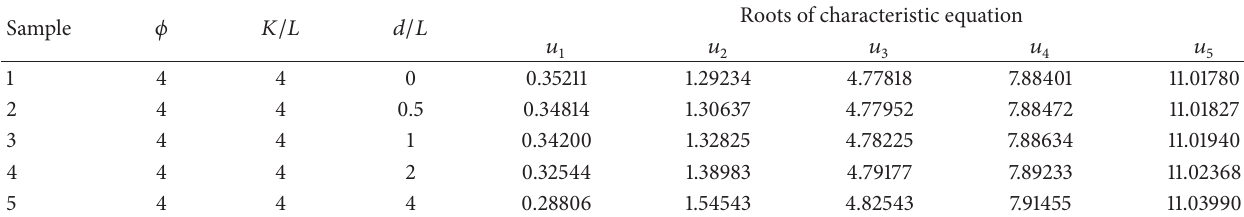
Table 1: Typical roots of characteristic equation with variables 𝜙 , 𝑘/𝐿 , and 𝑑/𝐿 .